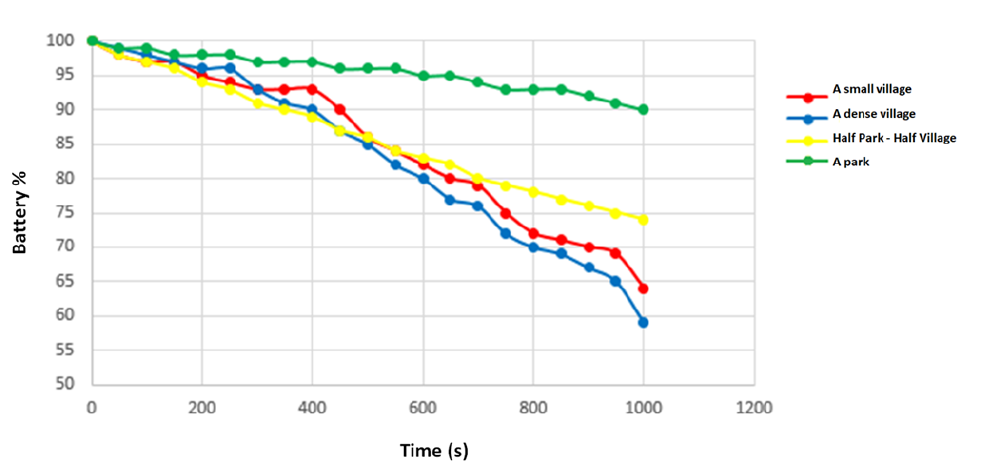
Figure 13. Battery performance test over